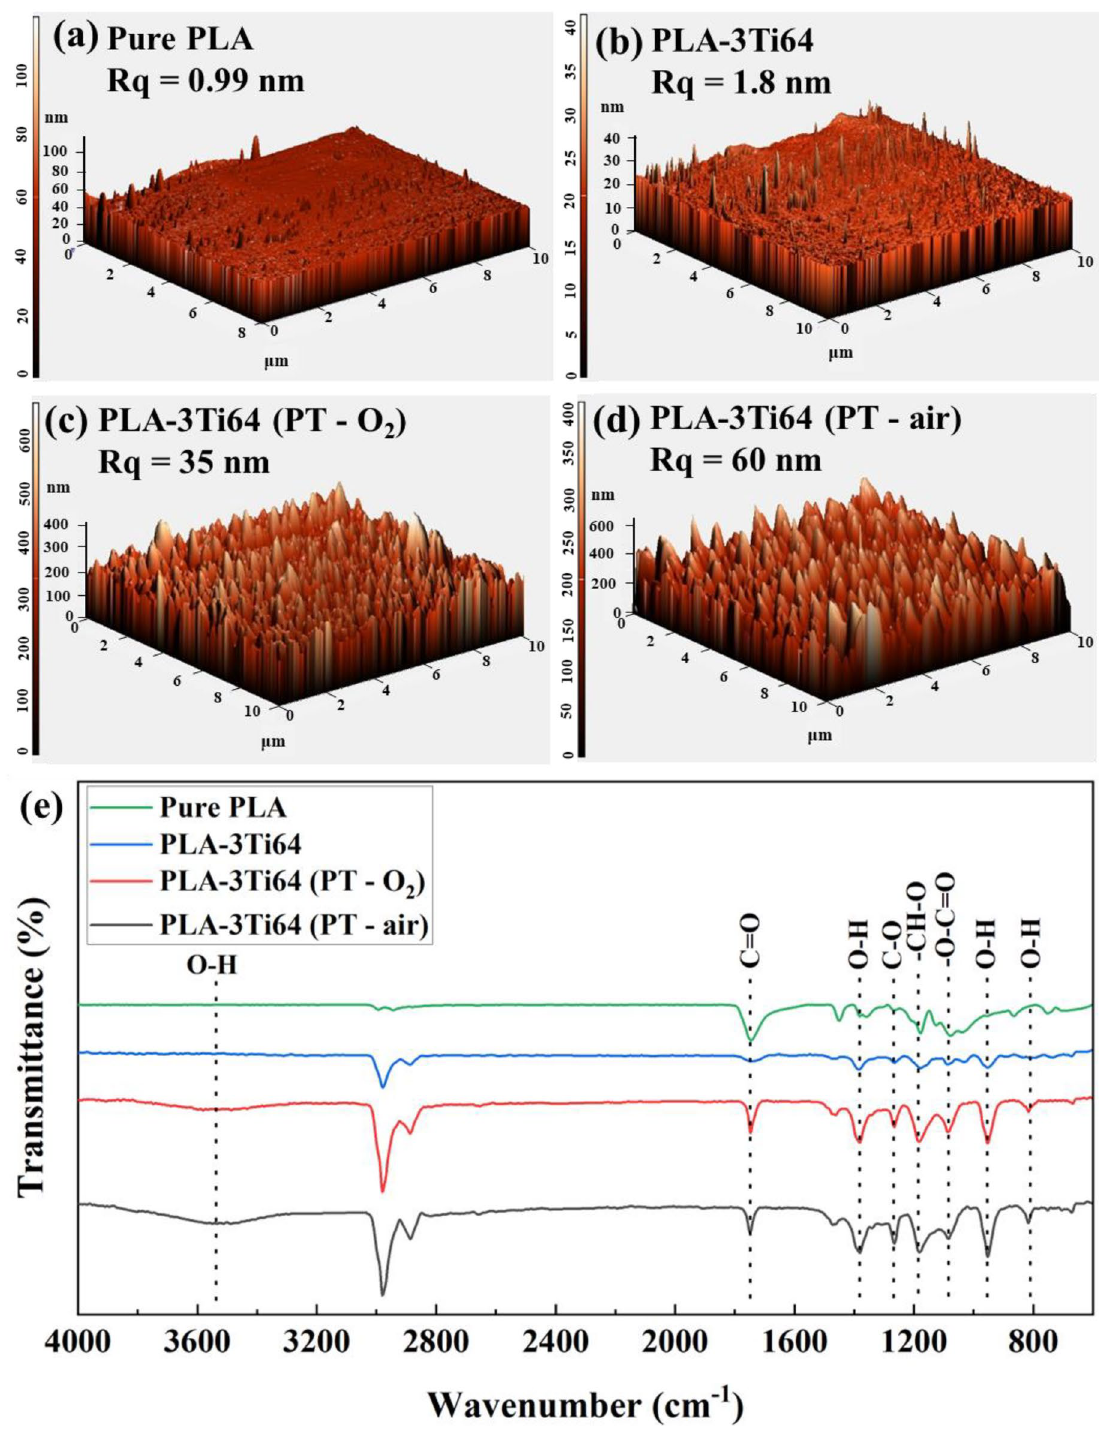
Figure 7. AFM results of 3D-printed samples of untreated pure PLA ( a ), untreated PLA-3Ti64 ( b ), PLA- 3Ti64 (PT-O 2 ) ( c ), and PLA-3Ti64 (PT-air) ( d ). (Images ( a – d ) were generated by NOVA softwarehttps:// www. ntmdt- si. com/ produ cts/ afm- featu res/ nova- px- contr ol- progr am (NT-MDT, version 1.0.26.1443 )). ATR-FTIR of untreated and treated samples ( e